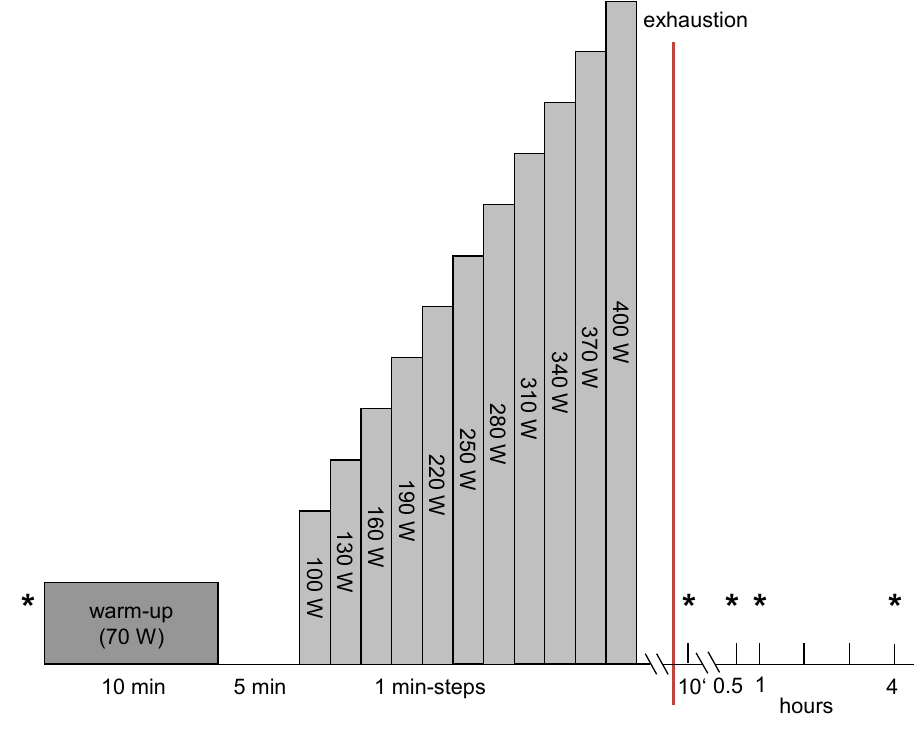
Figure 1. Exercise protocol. * = venous blood samples.